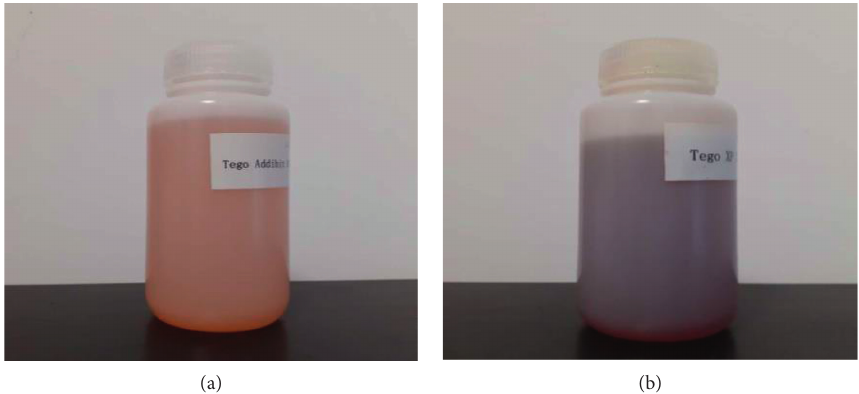
Figure 1: Silicone warm mix additives (a) Tego Addibit and (b) Tego